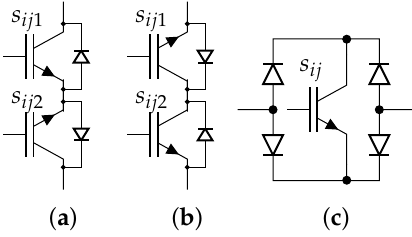
Figure 2. BDS topologies: ( a ) common-emitter, ( b ) common-collector, and ( c ) diode